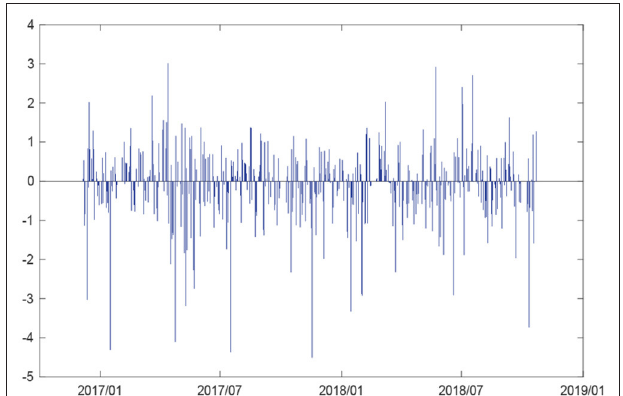
FIGURE 6 | Residual sequence of wind power.